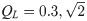
The accessible region of filter shapes depends on Q
L and the relative speed of spiking to intrinsic dynamics ξ = τw/τc.The purple region marks the region of voltage resonant filters. This region is contained in the red region of stable filters, whose lower bound moves to larger ν
ωL with Q
L. For relatively slow intrinsic spiking (a, b, c), there are regions of non-spiking resonant(ν
∞ > ν
ωL), but voltage resonant filters. Filters for relatively fast intrinsic dynamics (d, e, f) only exist as high pass resonant filters for large Q
L. (Left to right: QL=0.3,2, 1.1. Top row: ξ = 10. Bottom row: ξ = 0.1).